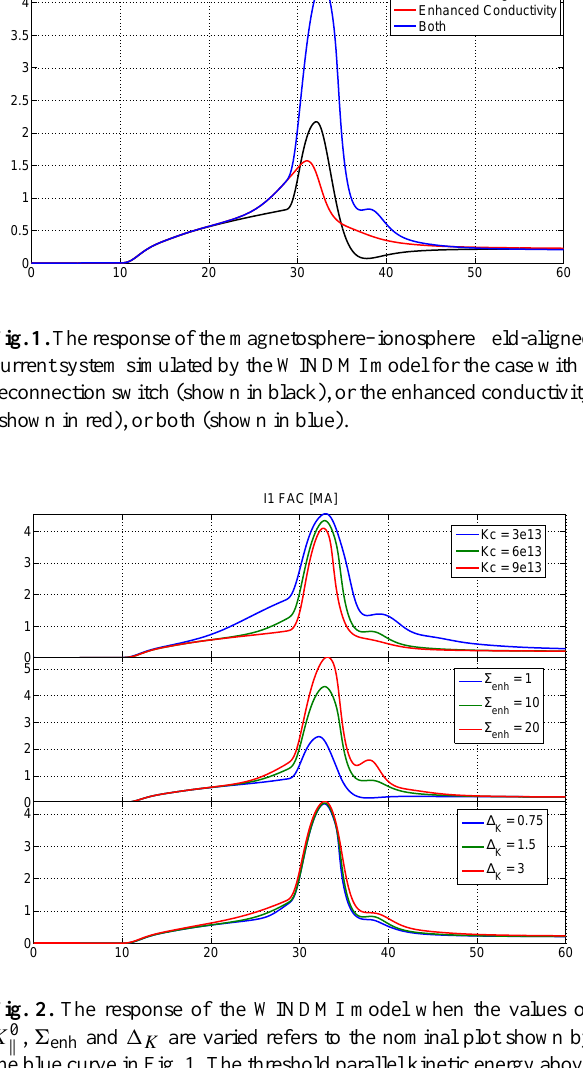
Fig. 1. The response of the magnetosphere-ionosphere field aligned current system simulated by the WINDMI model for the case with a reconnection switch (shown in black), or the enhanced conductivity (shown in red), or both (shown in blue).